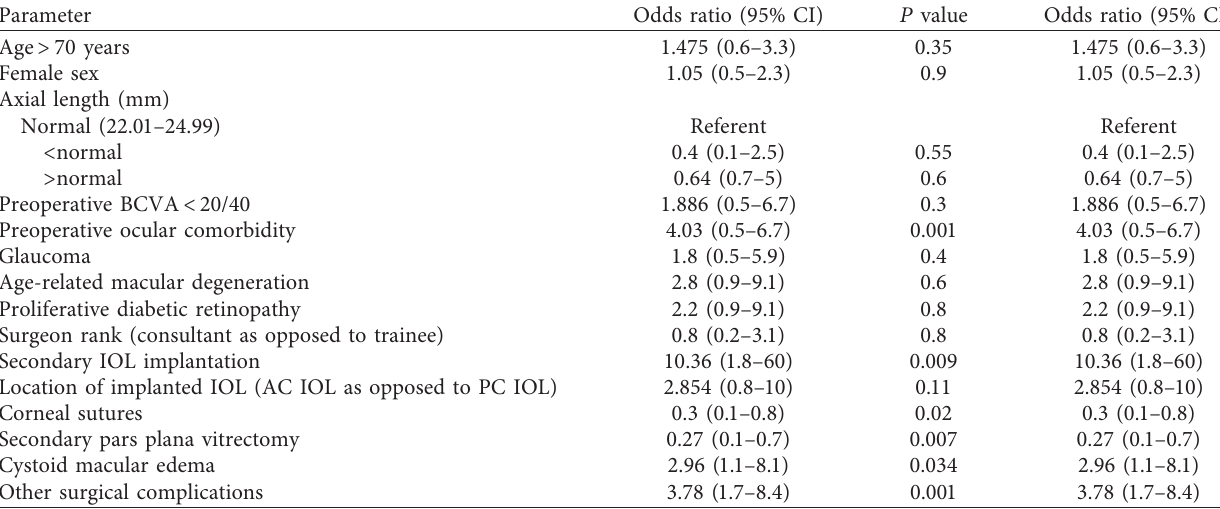
Table 1: Univariate analysis of potential parameters associated with low visual outcome.